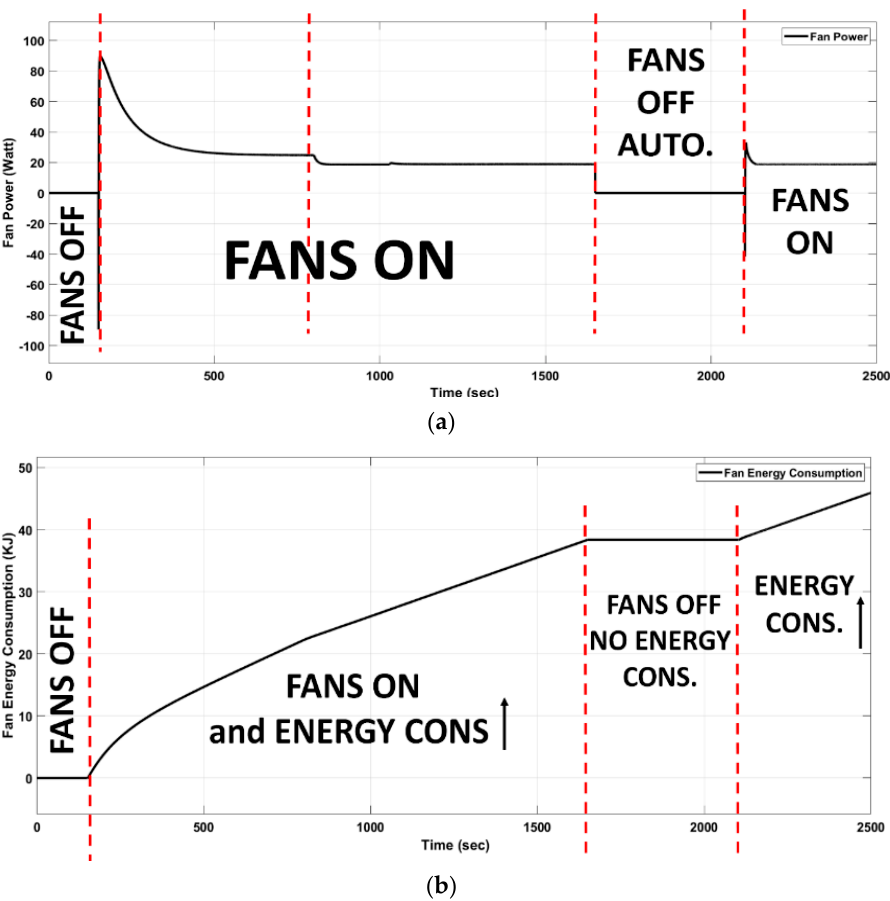
Figure 5. ( a ) The power consumption of a fan. ( b ) The energy consumption of a